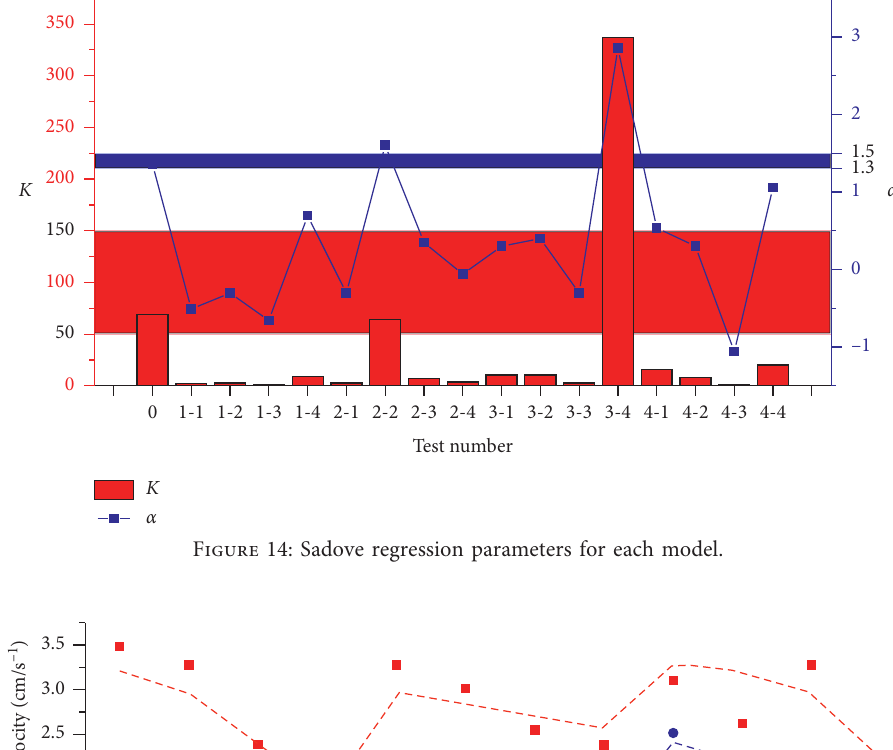
Figure 14: Sadove regression parameters for each model.